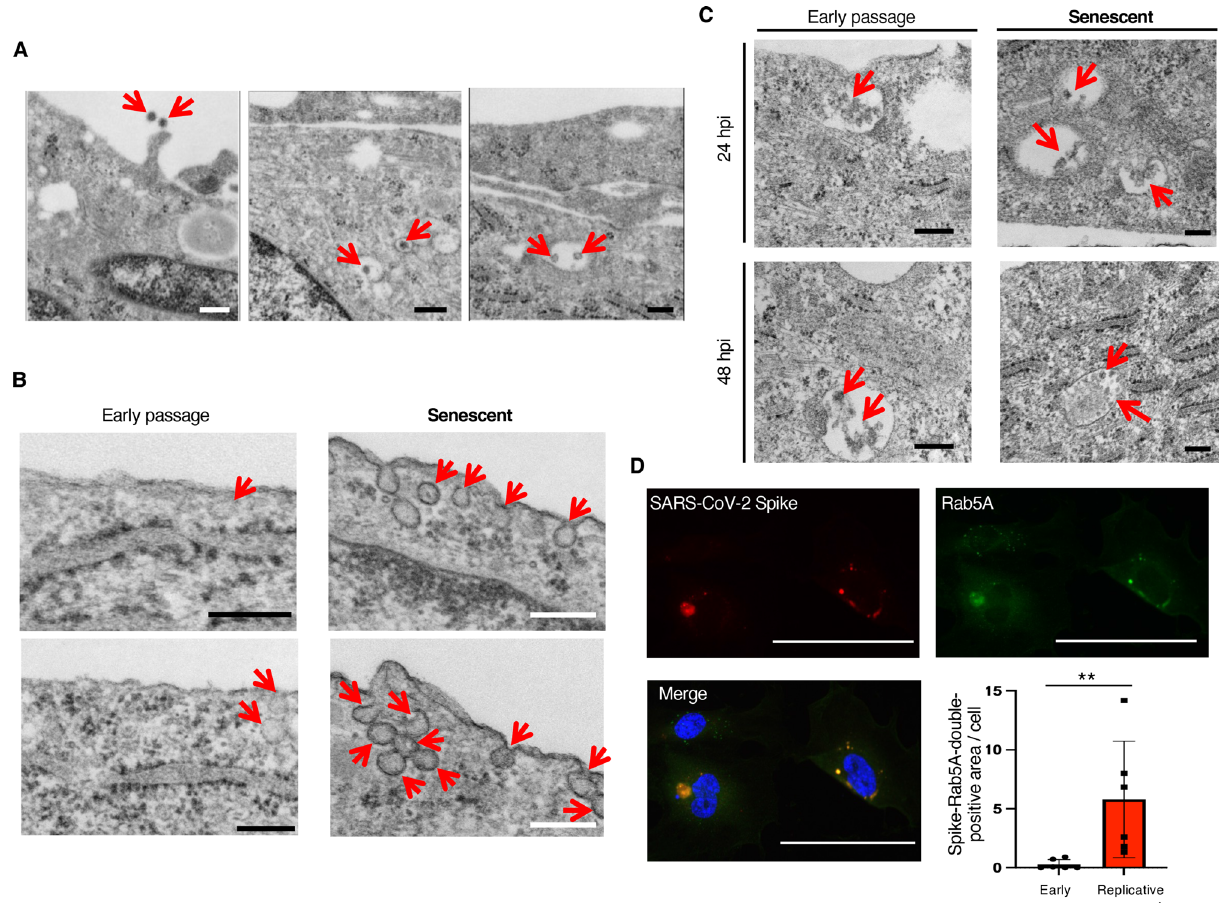
Figure 2. SARS-CoV-2 enters into ECs through endocytosis. ( A ) Representative electron microscopy images (× 80,000) for senescent HUVECs infected with SARS-CoV-2 at 50 MOI (2 hpi). Arrows indicate SARS- CoV-2 virions. Bars: 200 nm. ( B ) Representative electron microscopy images (× 80,000) for early passage and senescent ECs infected with SARS-CoV-2 at 1 MOI (6 hpi). Arrows indicate SARS-CoV-2 entry via caveolae- like structures. Bars: 200 nm. ( C ) Representative electron microscopy images (× 80,000) for early passage and senescent ECs infected with SARS-CoV-2 at 1 MOI (24 and 48 hpi). Arrows indicate SARS-CoV-2 virions. Bars: 200 nm. ( D ) Representative images of immunocytochemistry for SARS-CoV-2 spike protein (red fluorescence) and Rab5A (green fluorescence) in replicative senescent HUVECs infected with SARS-CoV-2 (50 MOI) at 6 hpi. SARS-CoV-2 spike proteins were largely co-localized with Rab5A. Bars: 100 μm. Spike and Rab5A double- positive areas were quantitatively analyzed (n = 6 each). Statistical analysis was performed using Mann Whitney U -test. Data are presented as mean ± SE ** P <